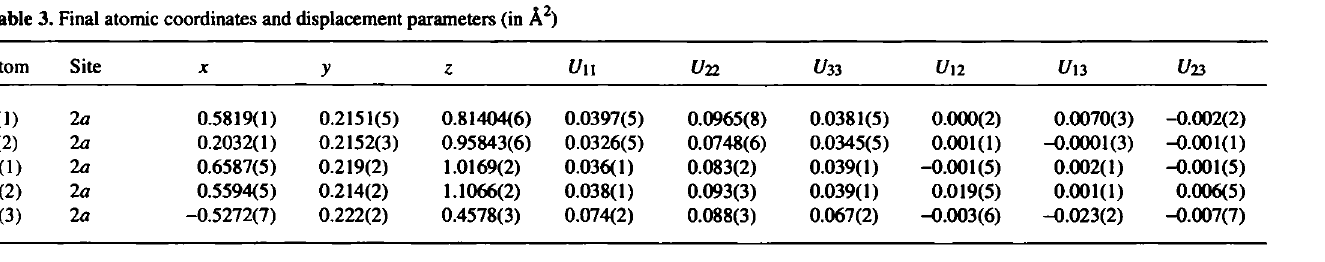
Table 3. Final atomic coordinates and displacement parameters (in Â^)